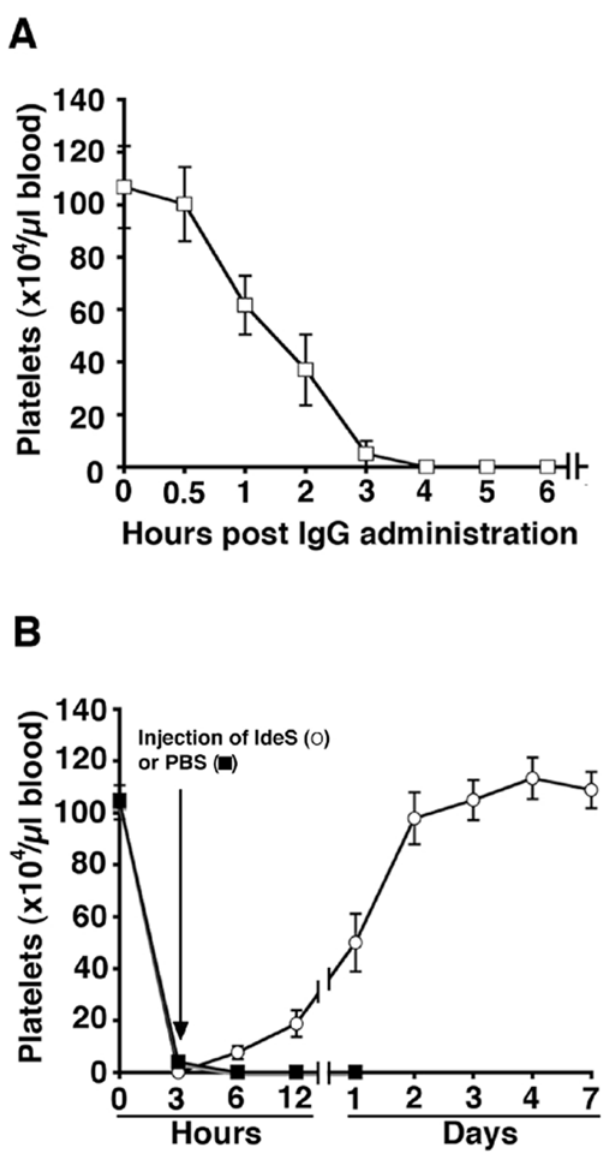
Figure 5. IdeS treatment of thrombocytopenia is effective also when initiated at low platelet levels. (A) Blood samples were taken at regular time intervals from three mice injected i.p. with a lethal dose of rabbit anti-mouse platelet IgG antibodies (1 mg IgG/mouse), and the number of platelets was determined by manual counting. ( B) An additional ten mice were injected with the lethal dose of IgG. At three hours, five mice were treated i.v. with IdeS (0.5 mg in 0.25 ml PBS/ mouse), while the other five received PBS alone (0.25 ml i.v/mouse). The PBS treated animals remained thrombocytopenic and died within 18– 30 hours of IgG administration, whereas the IdeS treated animals all recovered their platelet levels and survived. These animals were sacrificed on day